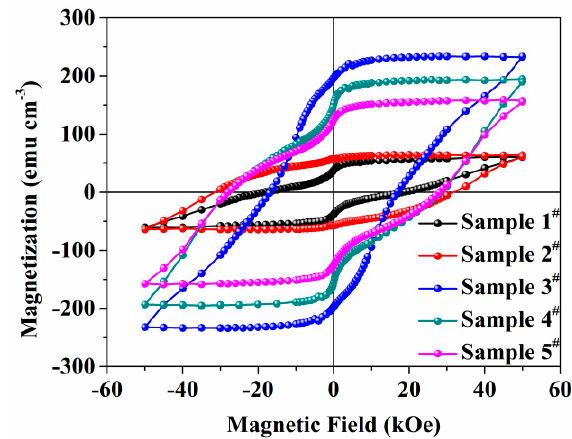
Figure 5. Out-plane field dependence of magnetization recorded at 300K for FePt/MgO nanocomposite